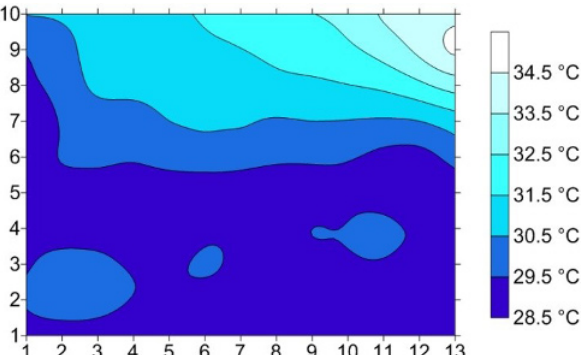
Fig. 12. The cut of the modified thermogram of the hot air stream measuring in the front passenger area by hand-held measuring After stabilizing the temperature inside car, the measurements in the central axis of the car were performed with settings of middle outlets parallel to the net and by setting up side mouth outlets to maximum angle (60°) to the net.